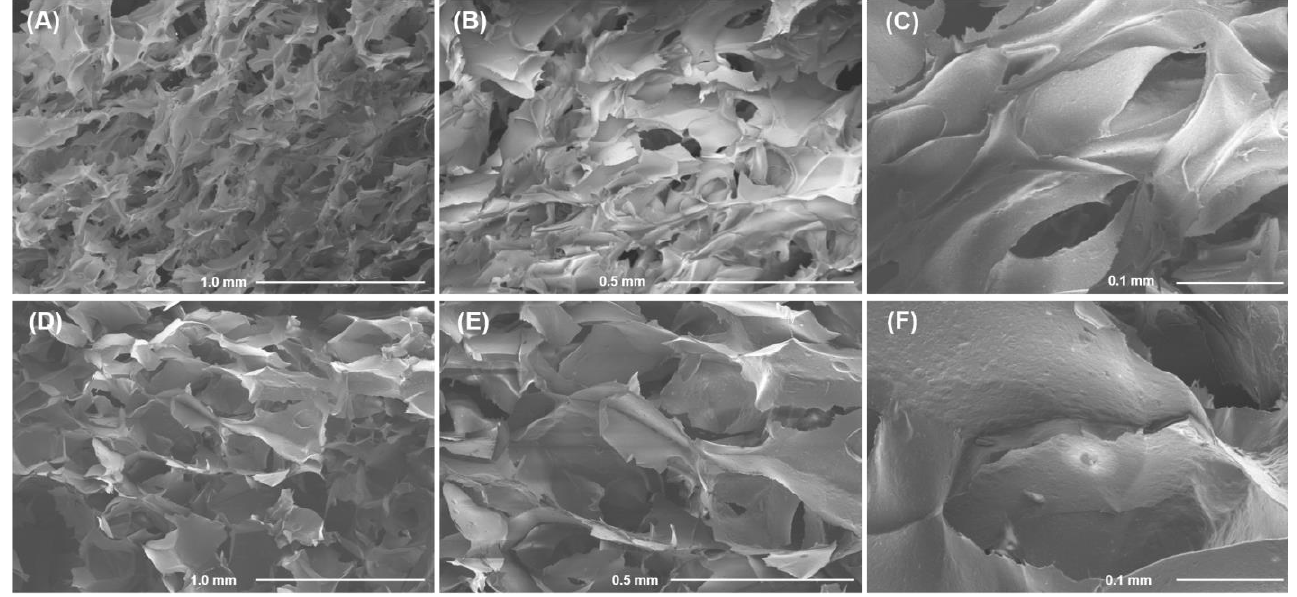
Figure 4. Scanning electron micrographs of the FeP ( A – C ) and CaP ( D – F ) hydrogels at 84 and 124 mM of Fe 3+ and Ca 2+ , respectively. Magnification 50×, scale bar 1.0 mm ( A , D ); magnification 100×, scale bar 0.5 mm ( B , E ); magnification 300×, scale bar 0.1 mm ( C , F ).